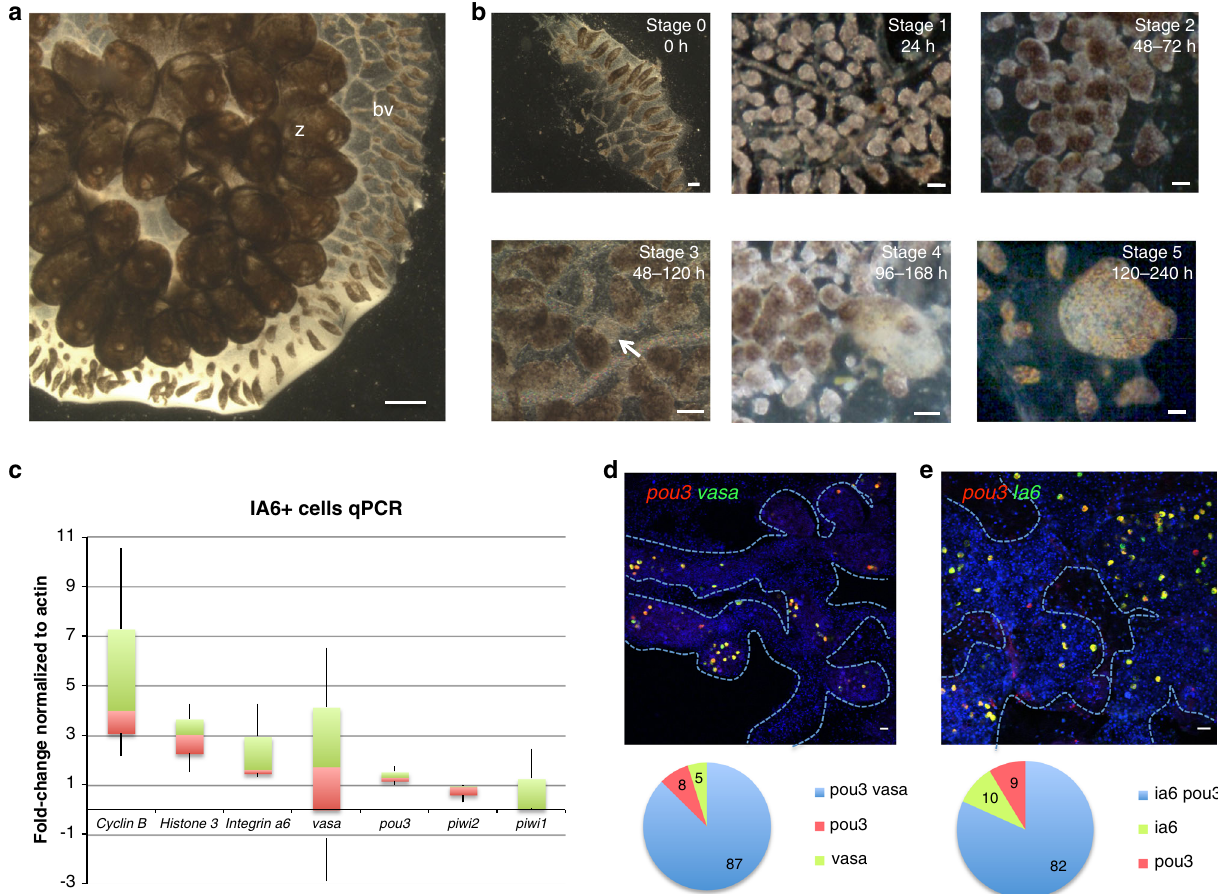
Fig. 1 Stages of whole body regeneration, gene expression in IA6 + cells. a Botrylloides diegensis , whole colony bright fi eld image, dorsal. Zooids (z) are embedded in a common, transparent tunic. Blood vessels (bv) extend throughout the tunic and are shared by the zooids of the colony. At the periphery of the colony, blood vessels form terminal sacs termed ampullae. Images are representatives of 20 independent experiments. Scale bar 1 mm. b Stages of whole body regeneration, bright fi eld images. Blood vessels are surgically separated from the colony (stage 0). During the fi rst 24 h, the blood vessel begins to remodel (stage 1). After 48 h, blood vessels become condensed and highly pigmented (stage 2). Regeneration begins when a double vesicle is formed, consisting of two layers of epithelium (stage 3, white arrow). This double vesicle undergoes organogenesis (stage 4) and gives rise to a new, fi lter feeding body (stage 5). Images are representatives of 20 independent experiments. Scale bars 200 μ m. c qPCR analysis showing expression of cyclin B, integrin- alpha-6, vasa, pou3, piwi2 , and piwi1 in IA6 + cells isolated by fl ow cytometry. Data are expressed as averages of fold changes normalized to actin , n = 4. Box plot shows interquartile range (the distance between the upper and lower quartiles) and whiskers indicate the minimum and maximum of the data. d FISH showing co-expression of pou3 (red) and vasa (green) in stage 0. DNA was stained with Hoechst (blue). Blue dashed lines outline blood vessel boundaries. Scale bar 20 μ m. Single-positive and double-positive cells were counted using the cell counter feature in FIJI, and for each stage, four images from four independent samples were counted. Pie graph shows averages of percentages of pou3/vasa -double-positive cells as well as pou3 and vasa single-positive cells. e FISH showing co-expression of pou3 (red) and ia6 (green) in stage 0. DNA was stained with Hoechst (blue). Blue dashed lines outline blood vessel boundaries. Scale bar 20 μ m. Single-positive and double-positive cells were counted using the cell counter feature in FIJI, and for each stage, four images from four independent samples were counted. Pie graph shows averages of percentages of pou3/ia6 -double-positive cells as well as pou3 and ia6 single- positive cells. Source data are provided as a Source Data fi